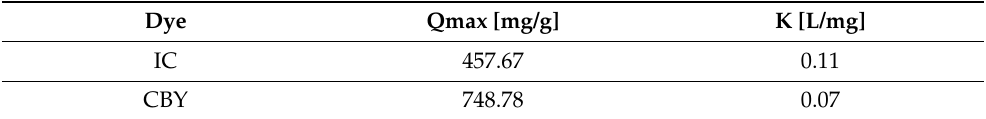
Table 1. Parameters of the Langmuir isotherm model for CBY and IC.